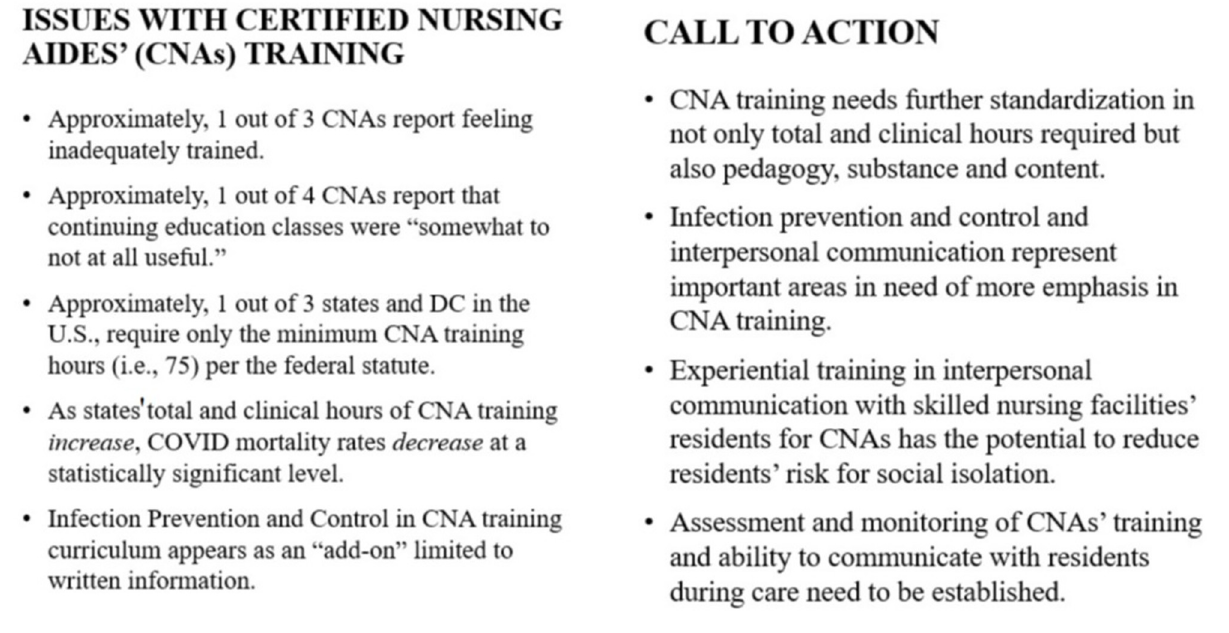
FIGURE 2 | Summary of issues & Call to Action: Improvement in Certified Nursing Aides’